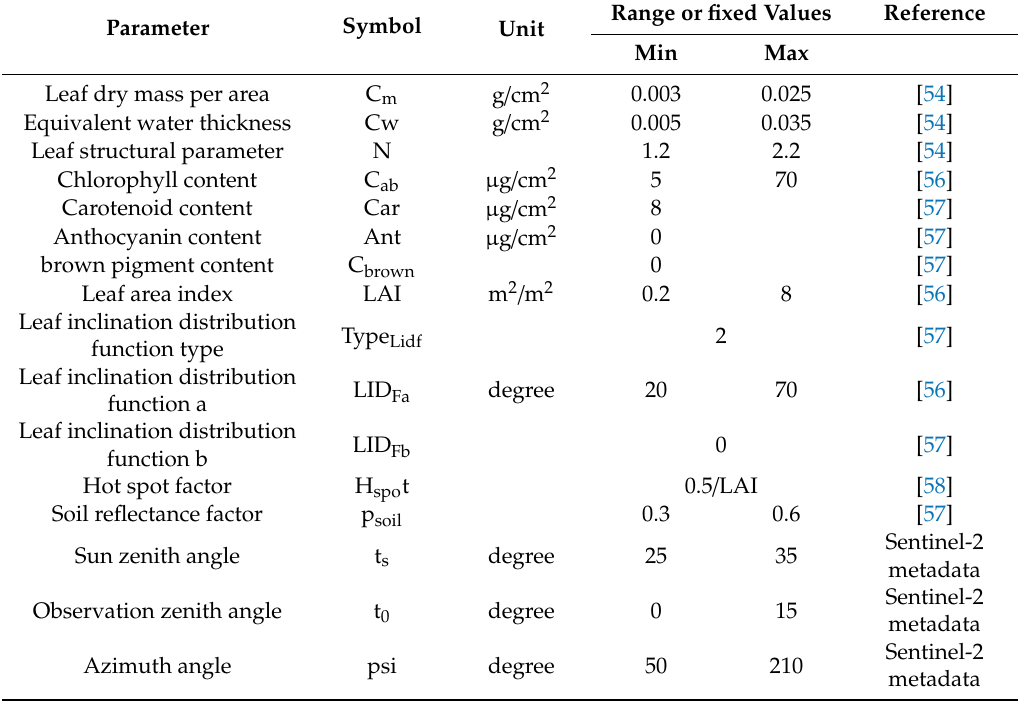
Table 4. PROSAIL radiative transfer model input parameters used to build the look-up table (LUT) and the corresponding values for wetland, taiga, and tundra